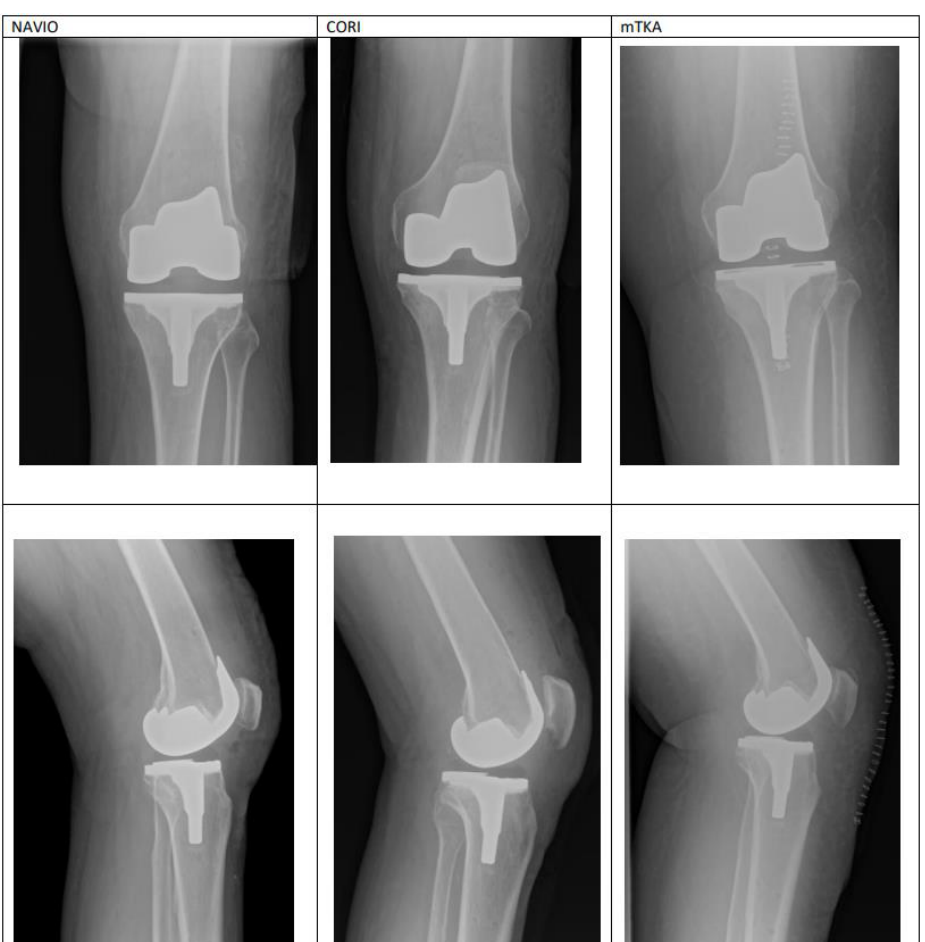
Figure 4. Control entitled X-rays from the day following each procedure: NAVIO and CORI ra-TKA, and mTKA.